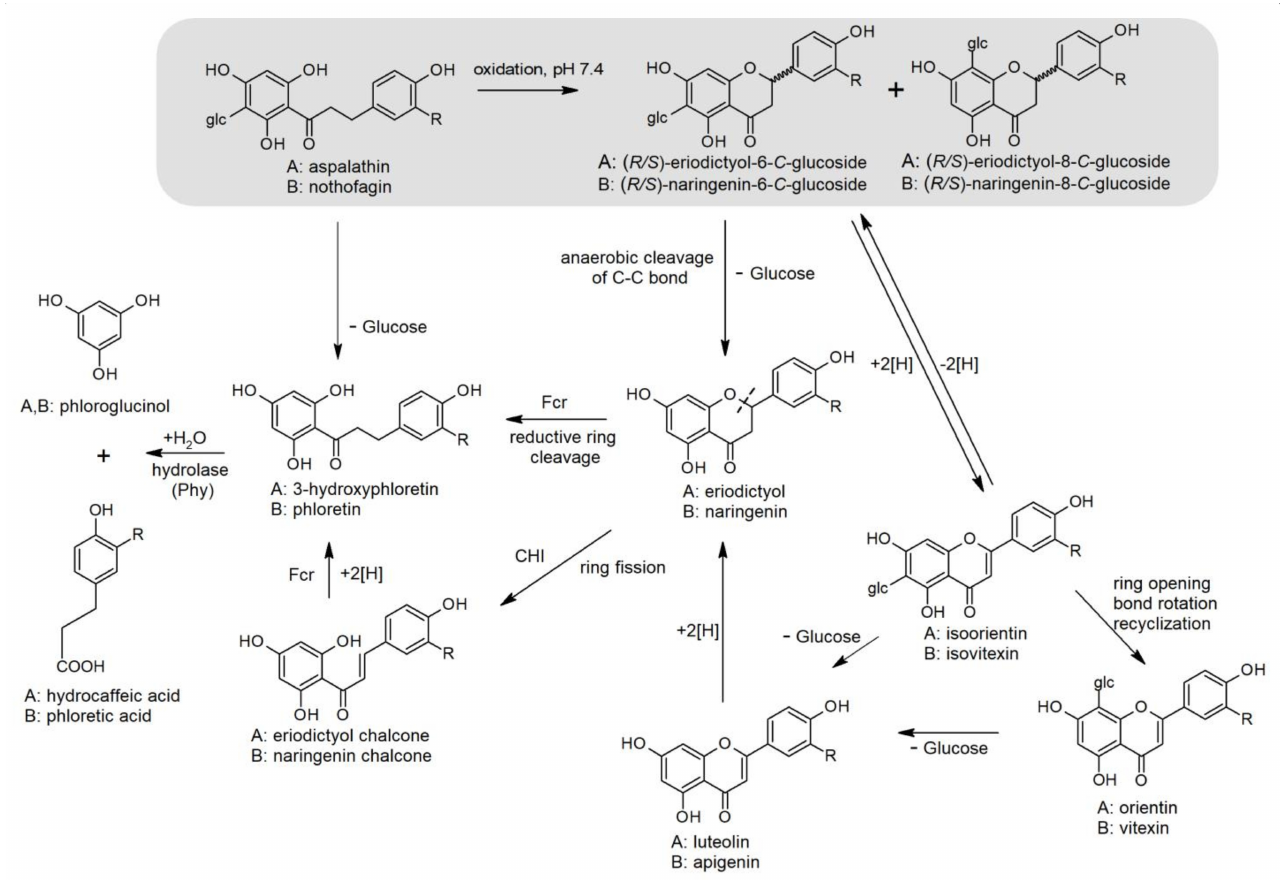
Figure 2. Proposed microbial degradation of aspalathin, nothofagin and their flavones, following non-microbial oxidative conversion at high pH conditions, found in the small intestine [69] (shaded area). The figure was adapted from Muller et al. [8]. Glc = glucose; R = OH for aspalathin and metabolites; R = H for nothofagin and